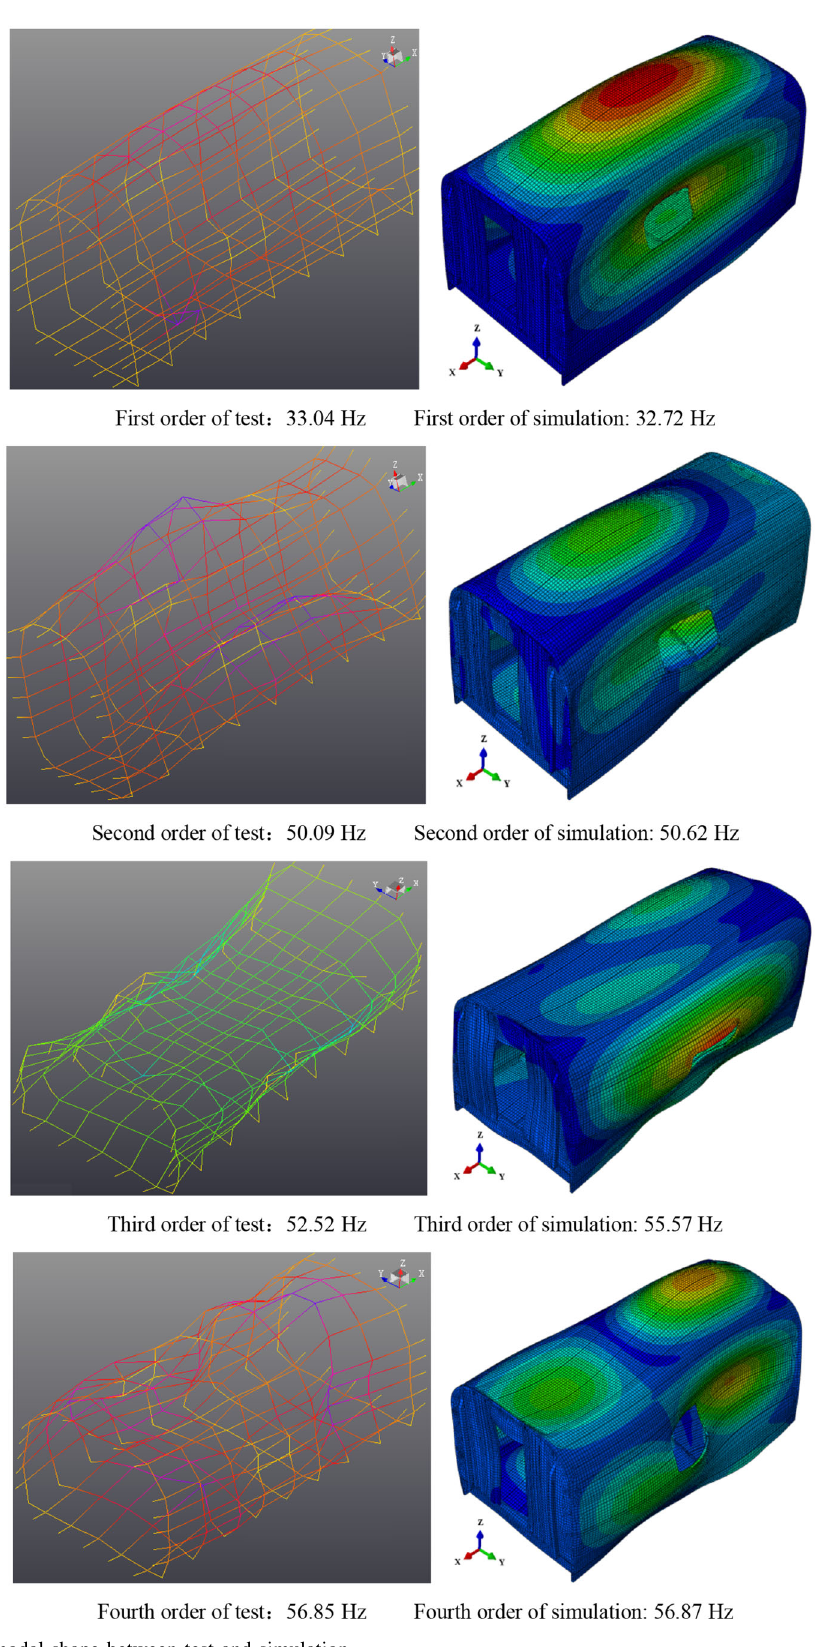
Fig. 4 Comparison of modal shape between test and simulation J. Mod. Transport. (2019)